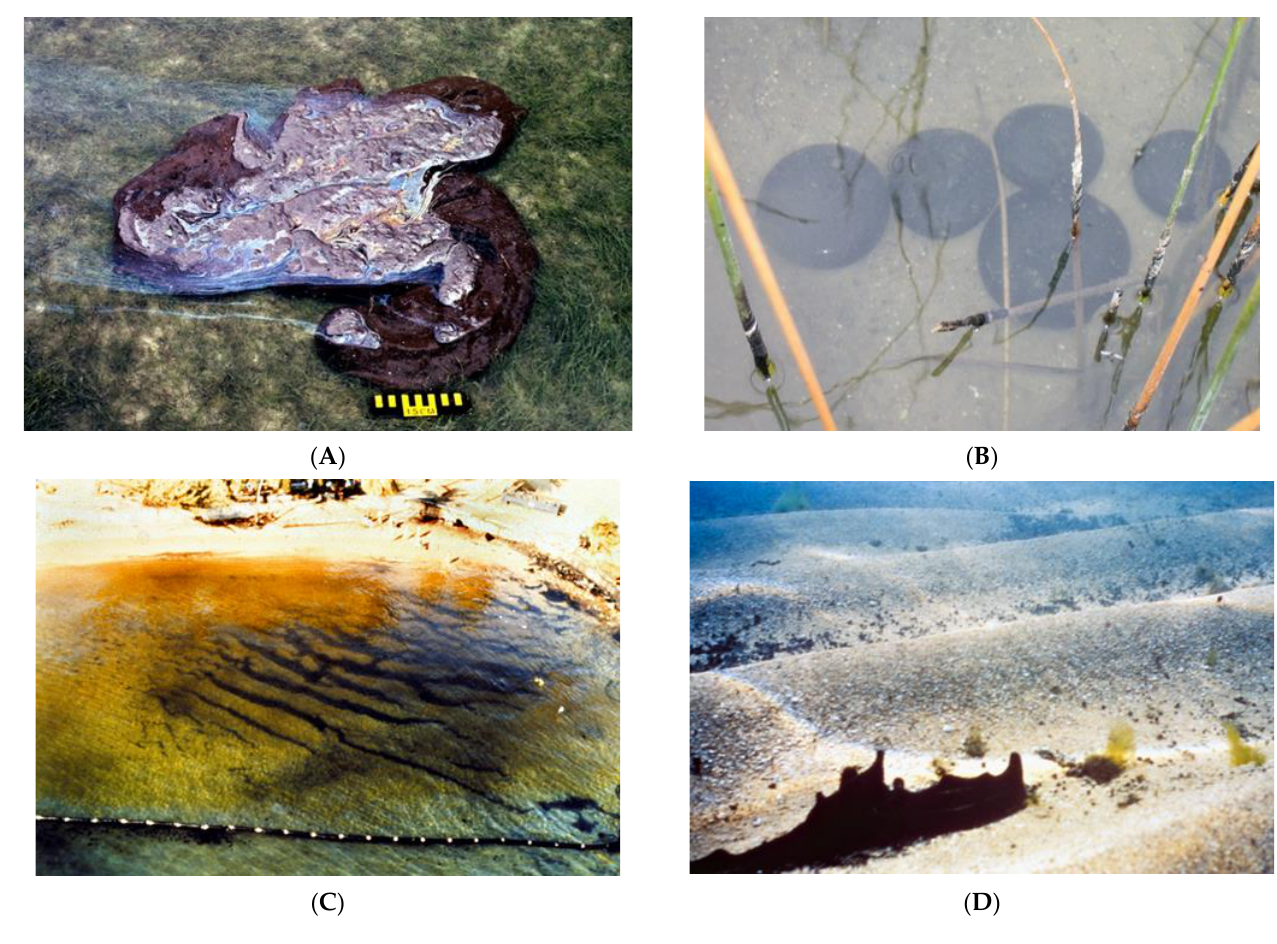
Figure 4. ( A ): Oily SOM floating just below the surface from the Bouchard 65 in Tampa Bay, FL. ( B ): Oily SOMs in the form of rounded “tarballs” in reed beds on the bottom of Lake Wabamun; some of these would rise and release sheens during the day [23]. ( C ): Oily SOM accumulation in a protected lagoon at the Morris J. Berman oil spill, Puerto Rico. The oil accumulated in the troughs between the sand waves, and there is no oil on the shoreline, meaning that the oil mixed with sand in the offshore environment. Boom is ~38 m long [15]. ( D ): Close up photograph of the SOM in C; the oil, which was still lighter than the water, refloated as daytime water temperature increased and the oil viscosity decreased, allowing the oil to separate from the sand [13].